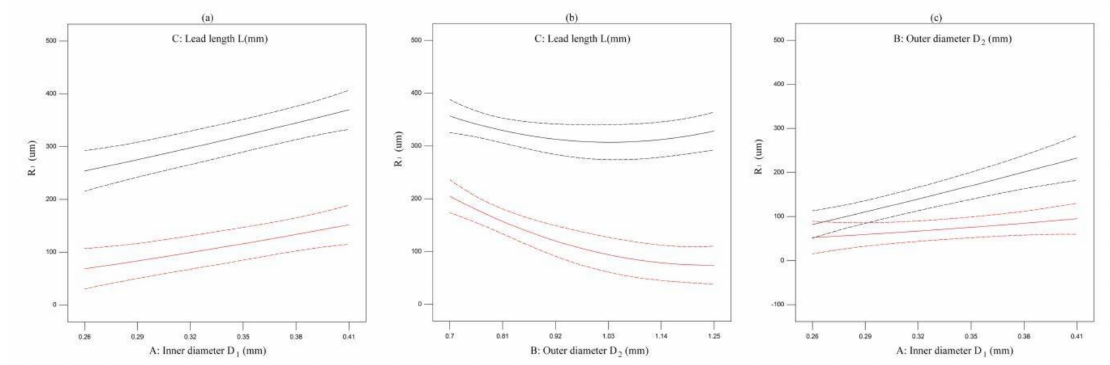
Figure 7. The e ff ect of multifactor interaction for the biomaterial diameter. ( a ) interaction term (AC), ( b ) interaction term (BC), ( c ) interaction term